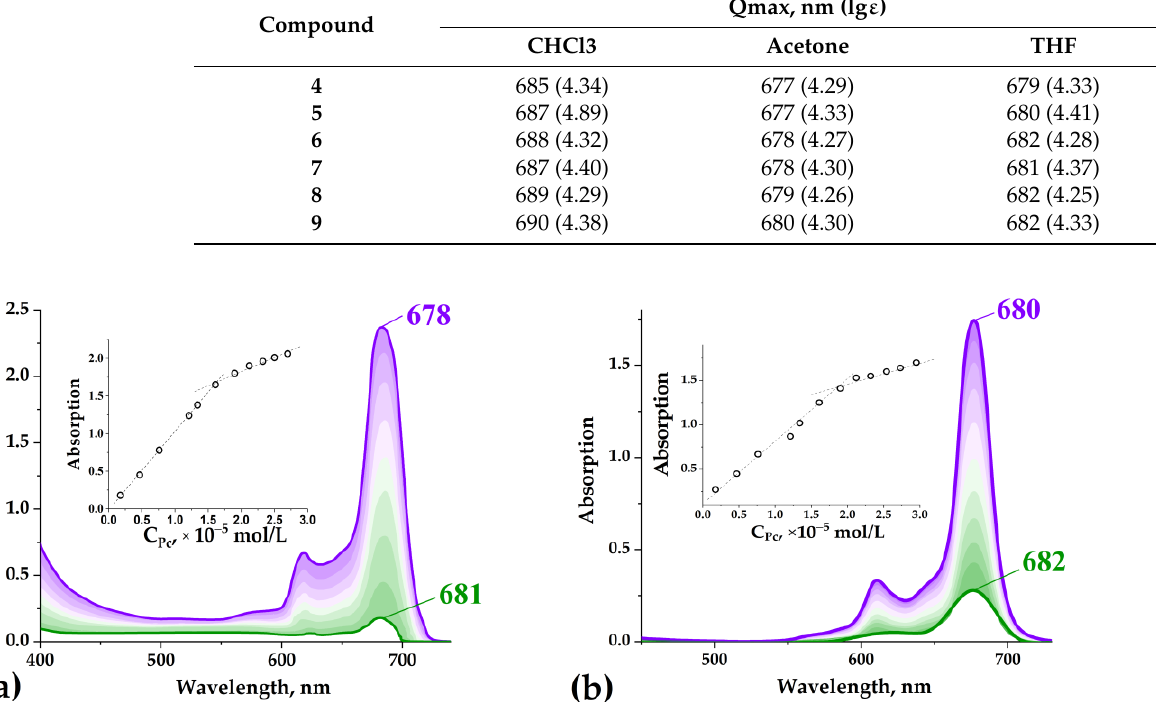
Figure 3. Changes in the electronic absorption spectra for solutions of compounds 6 ( a ) and 9 ( b ) in acetone upon dilution. Inserts show the dependencies of the optical density on the concentration of phthalocyanine in the solution.